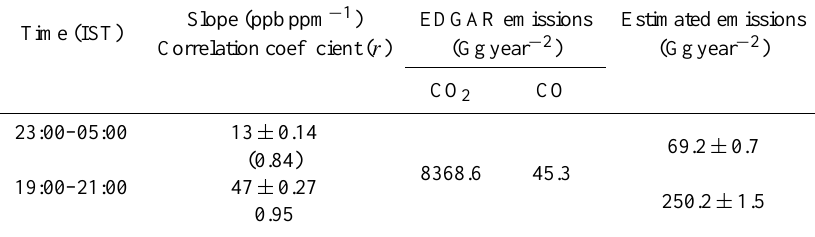
Table 3. Estimates of emissions of CO using CO 2 emissions from the EDGAR inventory over the box (72.3 < longitude < 72.7 ◦ E, 22.8 < latitude < 23.2 ◦ N) and observed CO (exc) : CO 2(exc) slopes for different time periods. The correlation coefficient for corresponding slopes are given inside the brackets in the slope column. Data for the summer monsoon season are not included for calculating slopes. Slope (ppbppm − 1 ) EDGAR Time (IST)